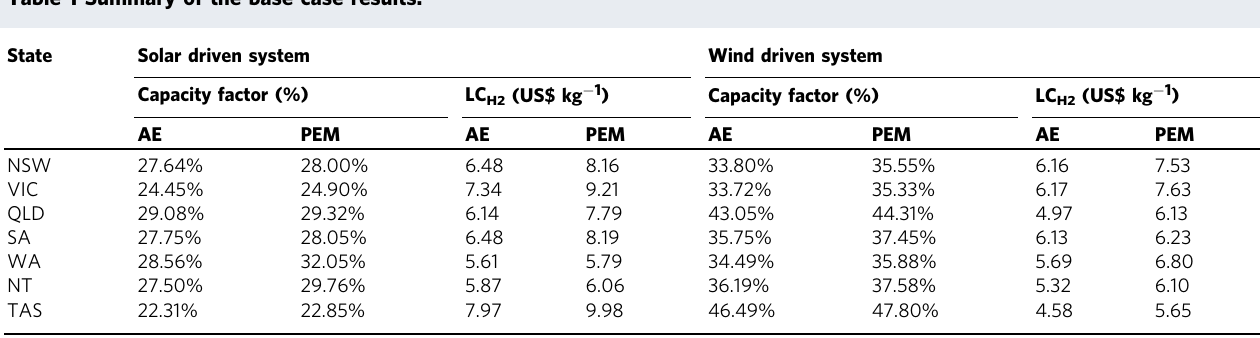
Table 1 Summary of the base case